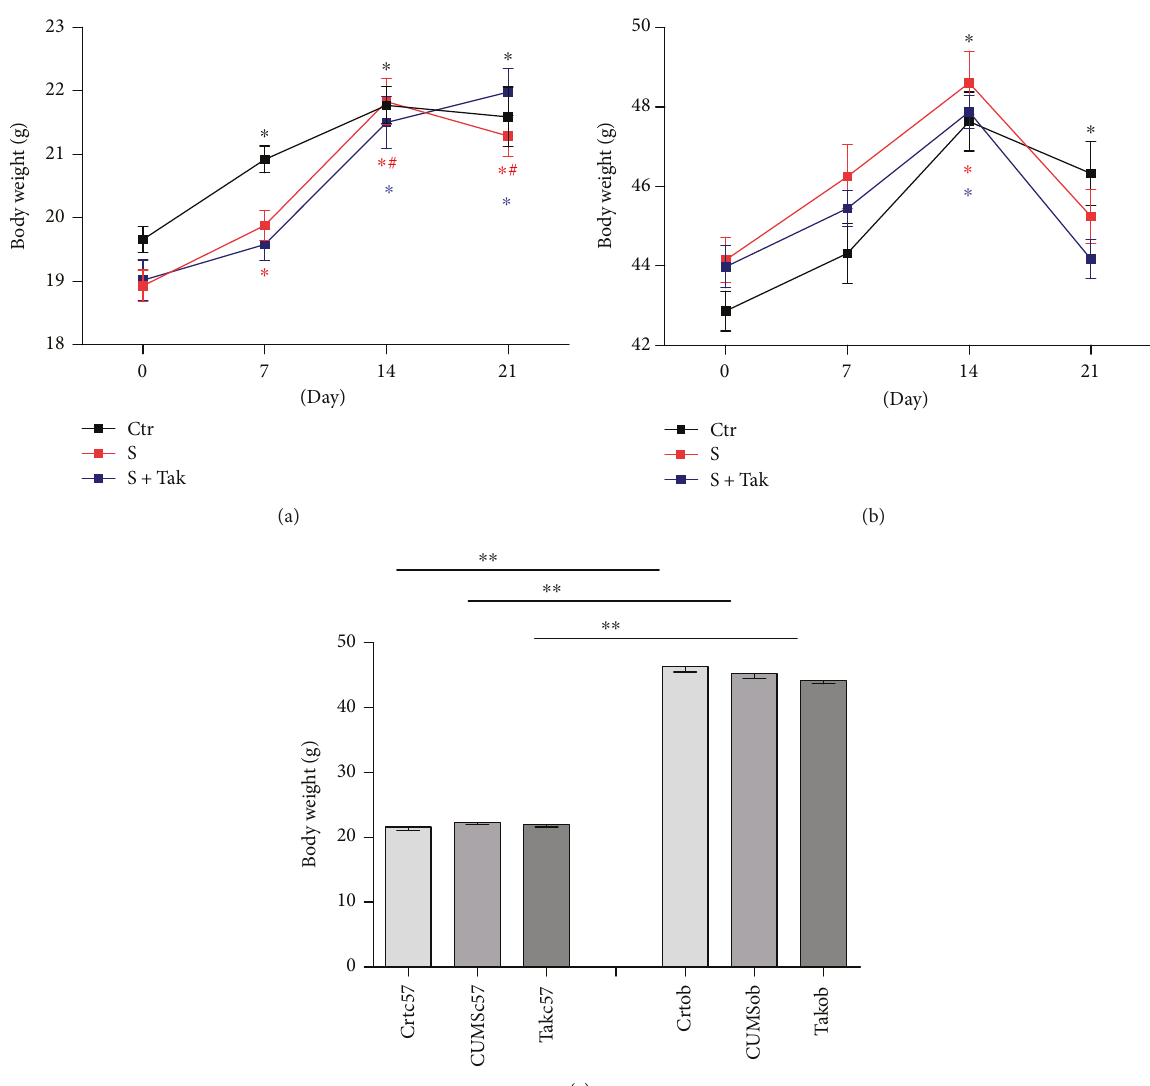
Figure 1: The comparison of body weight in di ff erent groups. (a) Body weight changes during CUMS of C57BL/6 mice; ∗ p < 0 05 compared with 0 day and # p < 0 05 compared with 7 days. (b) Body weight changes during CUMS of ob/ob mice; ∗ p < 0 05 compared with 14 days. (c) The body weight on the day after behavioral tests. Results are expressed as mean ± SEM ( n = 10 in each group); ∗∗ p < 0 01